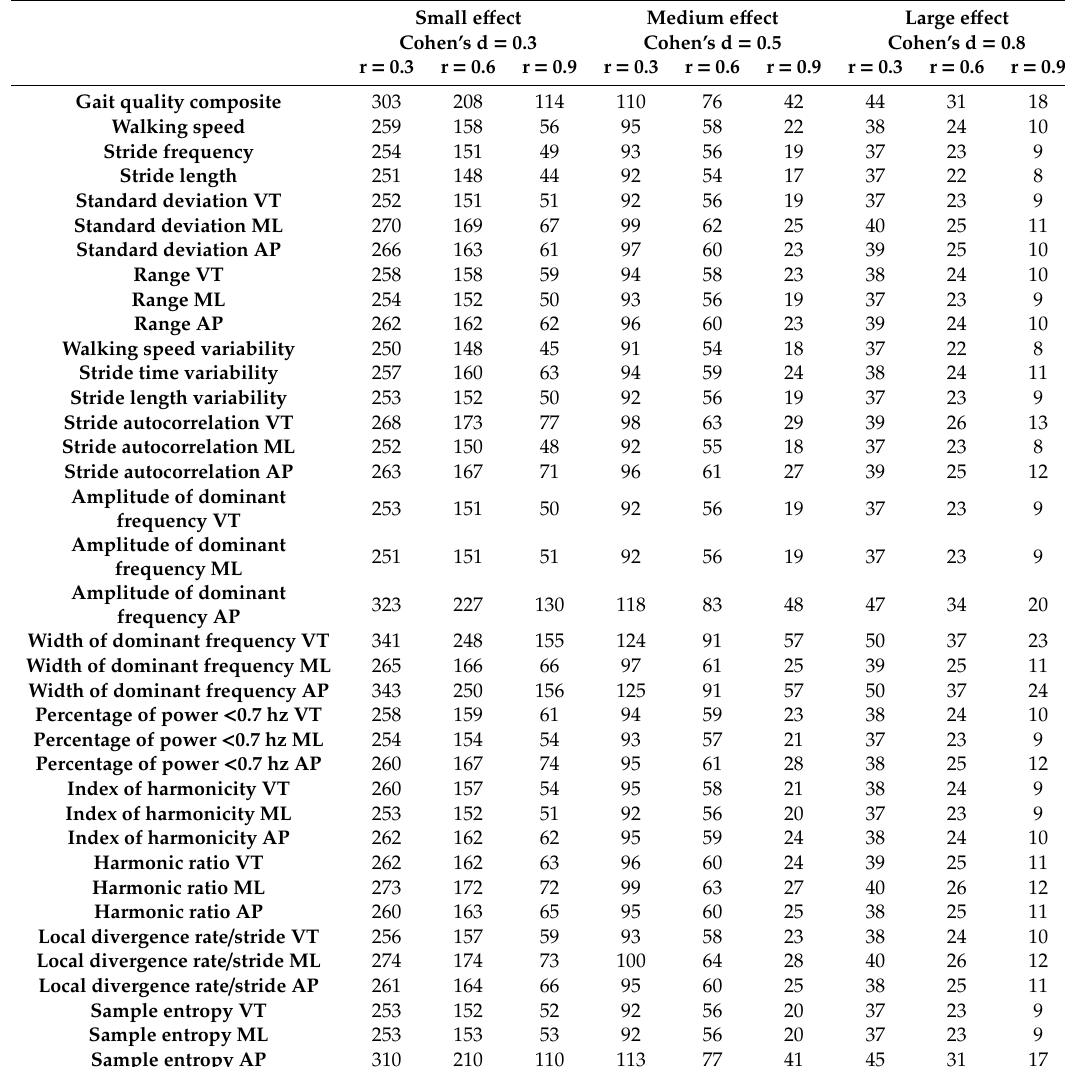
Table A2. Number of participants required for all gait